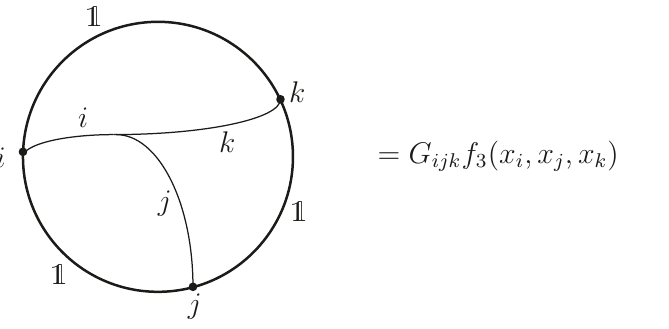
Figure 23 . A simple three-point function which depends on the gauge chosen for defect manipu- lation. The function f 3 ( x i , x j , x k ) is the part of the three-point-function which is completely fixed by conformal